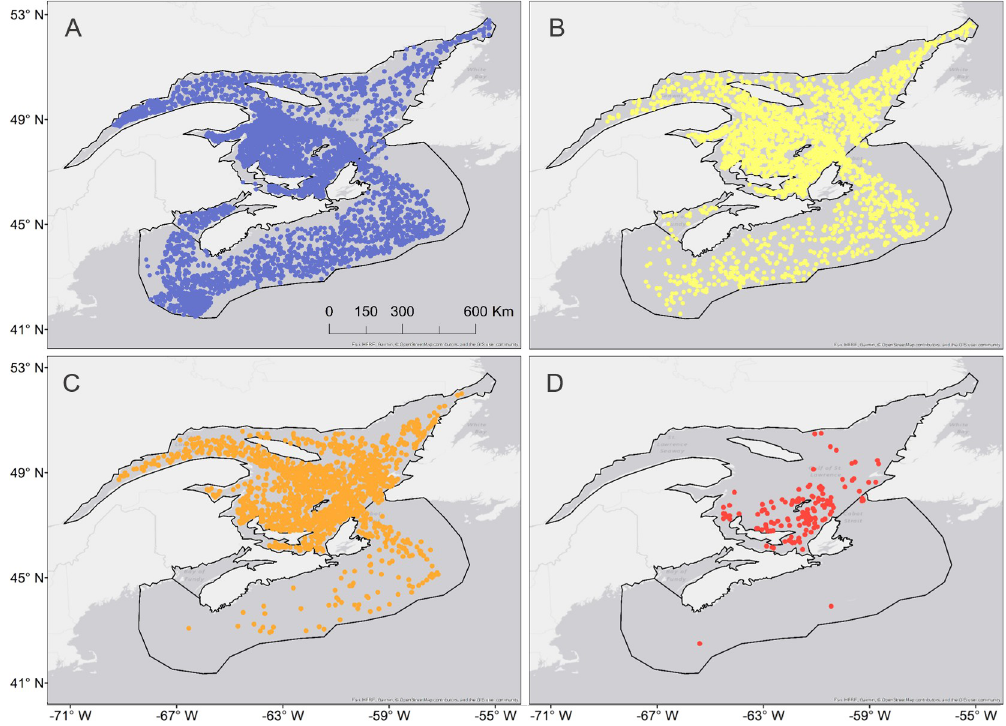
Fig 2. Jellyfish distribution by weight per survey tow. A) No jellyfish present in survey; B) Jellyfish present in survey, under 1kg (mostly likely between 1 to 5 individuals); C) Jellyfish present in survey, between 1 and 10kg biomass; and D) Jellyfish present in survey, over 10kg